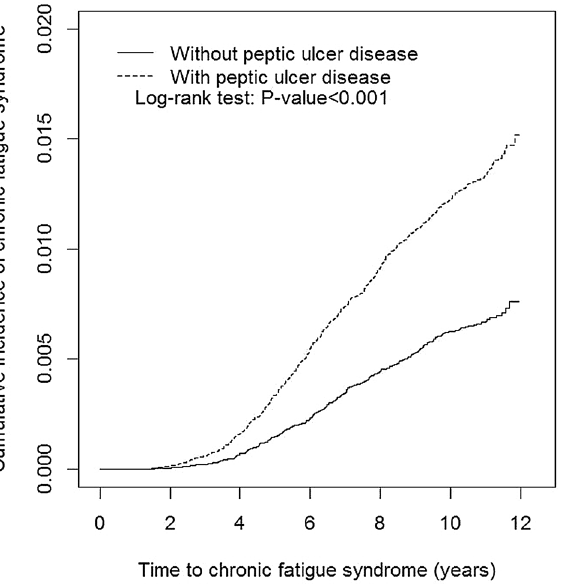
Figure 2. Cumulative incidence of chronic fatigue syndrome compared between patients with and without peptic ulcer disease using the Kaplan–Meier